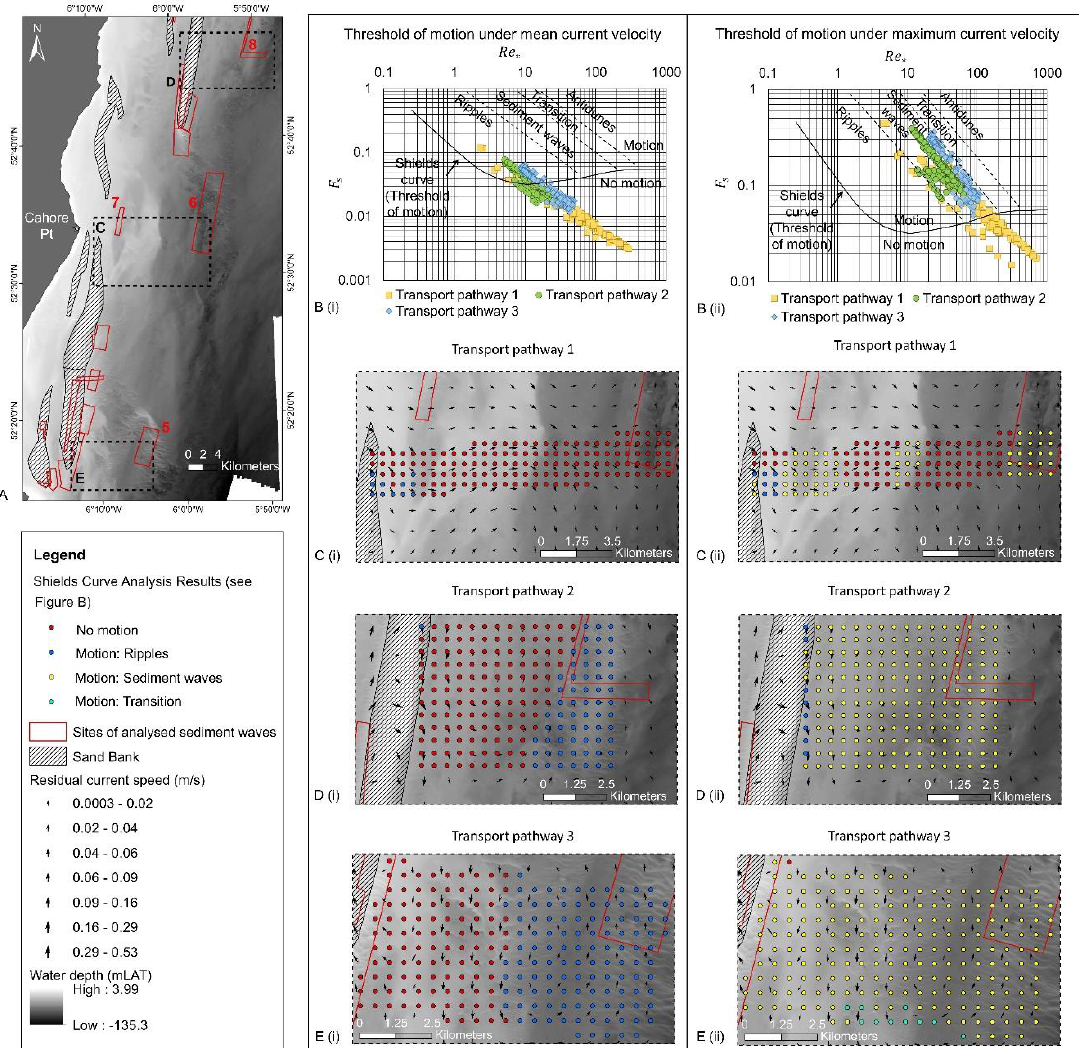
Figure 15. ( A ) The location of ( C – E ) in the south-western Irish Sea. ( Bi , Bii ): The Shields curve [86] overlain with values of 𝑅𝑒 ∗ and 𝐹 𝑠 derived from the sediment surface samples calculated under mean and maximum current velocities, respectively. Sampling locations are displayed in C to E, which form a 500 × 500 m grid that transects along residual circulatory cell systems 1, 2, and 3 outlined in Figure 13. From ( Bi , Bii ), each point is designated as (a) No motion or (b) Motion: Ripples, Sediment waves or Transition, the location of which are displayed in ( C – E ). Bathymetry source: INFOMAR (https://www.infomar.ie/data [Accessed: 10 June 2021])